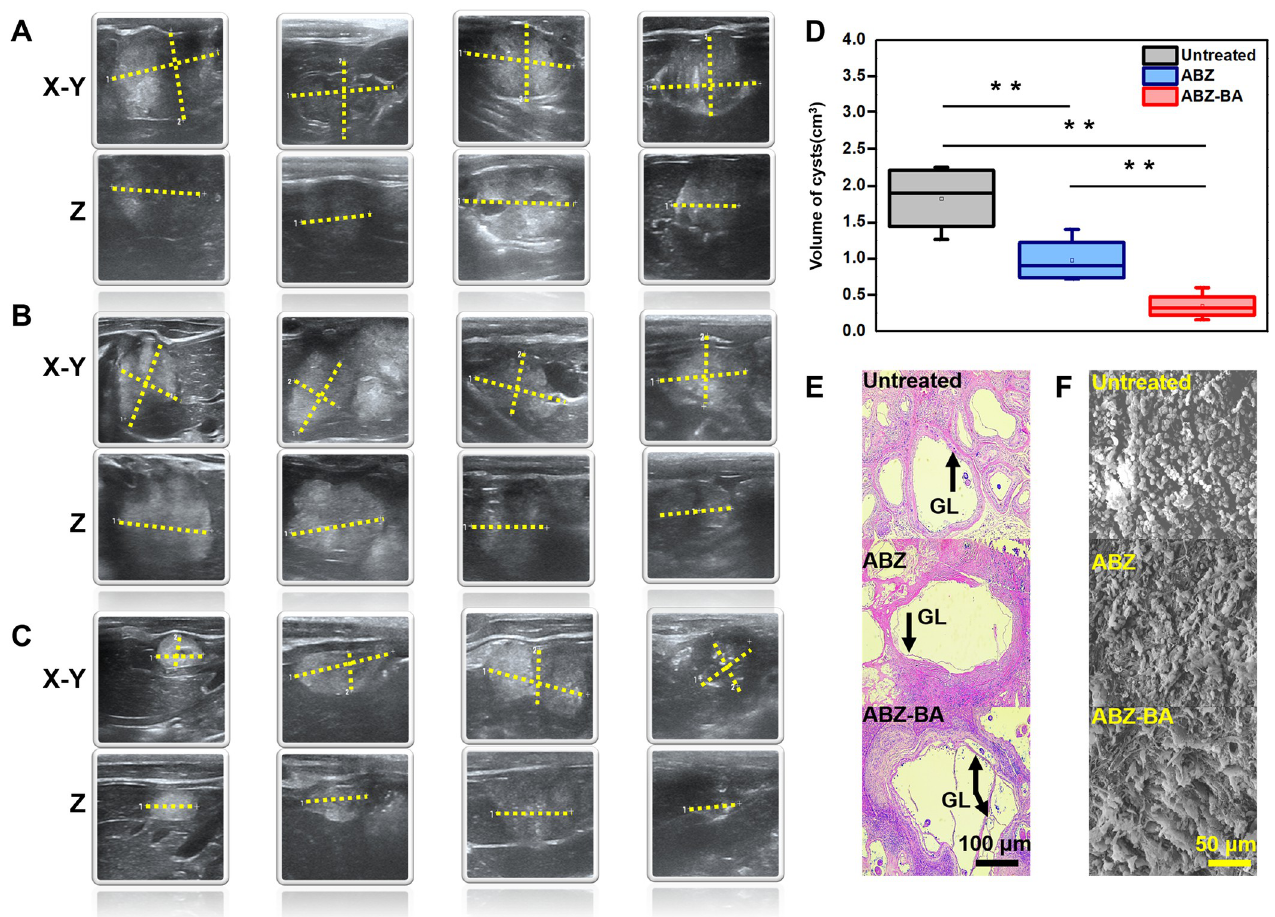
Fig 7. ABZ-preparation-driven pharmacodynamic analyses in secondary hepatic alveolar rats. (a)-(c). Cysts were observed in representative liver tissue (n = 6) after 30 days of administration of CMC-Na (a), Albenda (b), and ABZ-BA (c). The X-Y diagram and Z diagram (red) of each group represent the lesion size in the XY-axis and Z-axis directions, respectively. (d). Cysts volume from different treatments (n = 6). Data are expressed as the mean ± SD. One-way ANOVA test was used for inter-group comparisons, and Tukey’s t-test was used for multiple comparisons. P < 0.05 means the difference is statistically significant( � p < 0.05, �� p < 0.01). (e). Histological images (H&E staining) of cysis. GL, germinal layer. (f). SEM images of cysis after 30d treatment with different